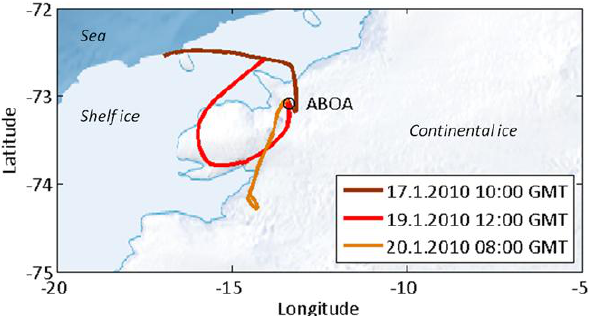
Fig. 5. The 24h HYSPLIT back trajectories during the observed local events from 17 to 20 January 2010. Each time the air mass Figure 5 The 24-hour HYSPLIT back-trajectories during the observed local events from 17 to 3 had been staying over the land and in the surrounding area over the 20 January 2010. Each time the airmass had been staying over the land and in the 4 last 24h. Continental and shelf ice are seen separately in the map. surrounding area over the last 24 hours. Continental and shelf ice are seen separately in the 5 According to the National Snow and Ice Data Center, the sea ice map. According to the National Snow and Ice Data Center (NSIDC), the sea ice edge next to 6 edge next to Aboa was more than a hundred kilometres from the shelf ice edge in January Aboa was more than hundred kilometres from the shelf ice edge on January 2010. 7